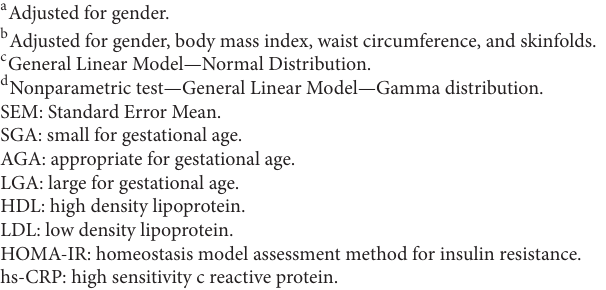
Blood parameters